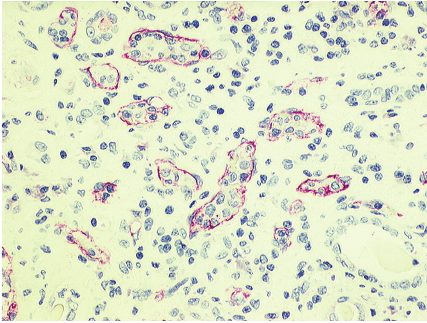
Figure 4: Attachment of C4d along the peritubular capillaries.